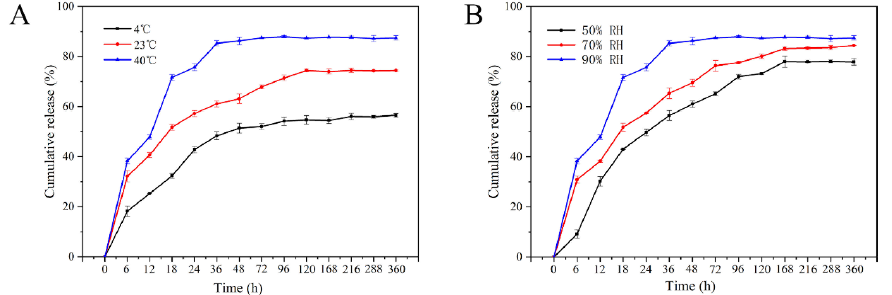
Figure 6. ( A ): Release curve of microcapsules at different temperatures (4, 23, and 40 °C); ( B ): Release curve of SiO 2 -CA microcapsules under different humidity conditions (50%, 70%, and 90% relative curve of SiO 2 -CA microcapsules under di ff erent humidity conditions (50%, 70%, and 90% relative humidity (RH)). humidity